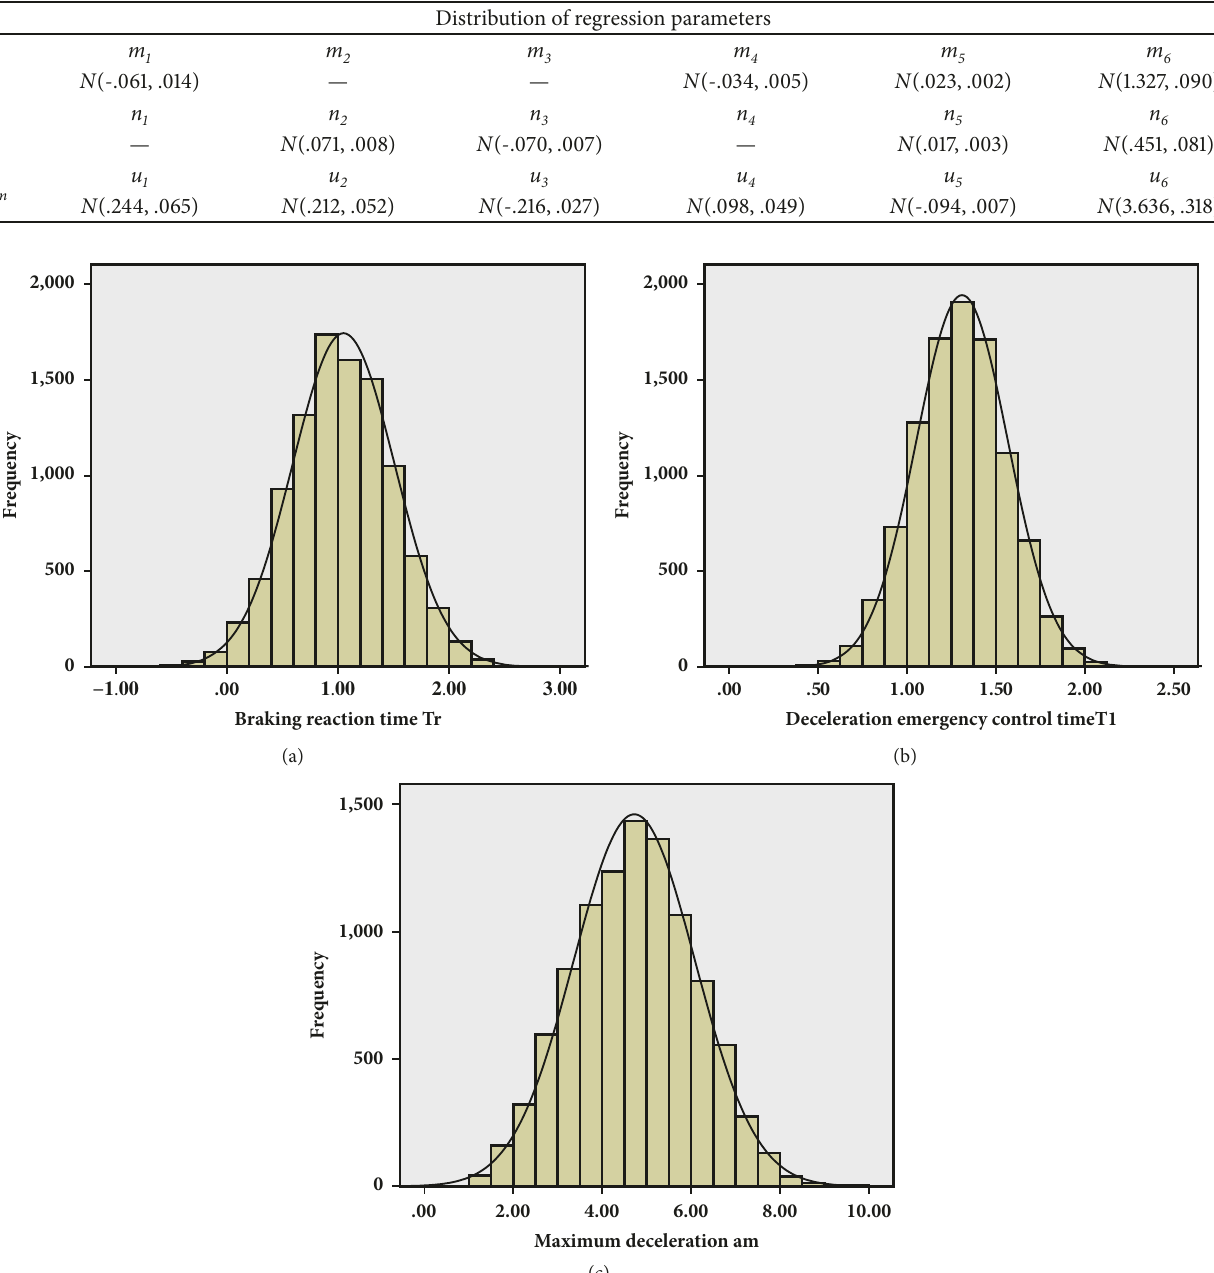
Table 3: Distributions of regression parameters with a 95% confidence interval for determining 𝑡 𝑟 , t Distribution of regression parameters